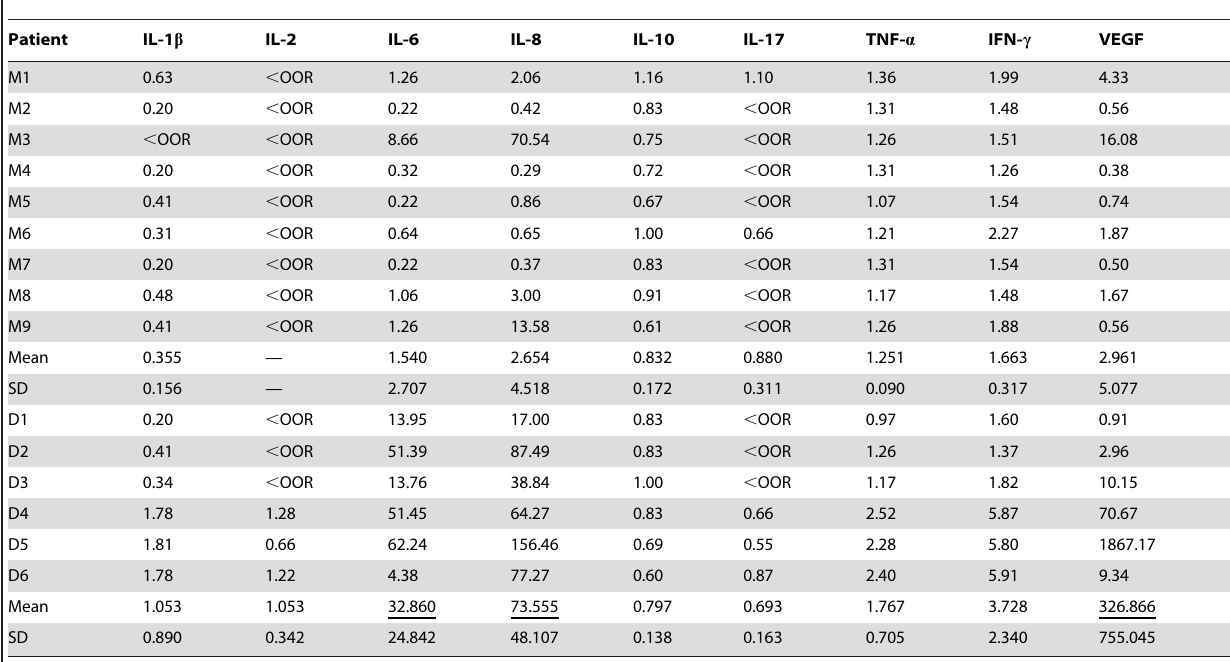
Table 3. 9 cytokines concentrations measured by Multiplex Assay in control groups (pg/ml).